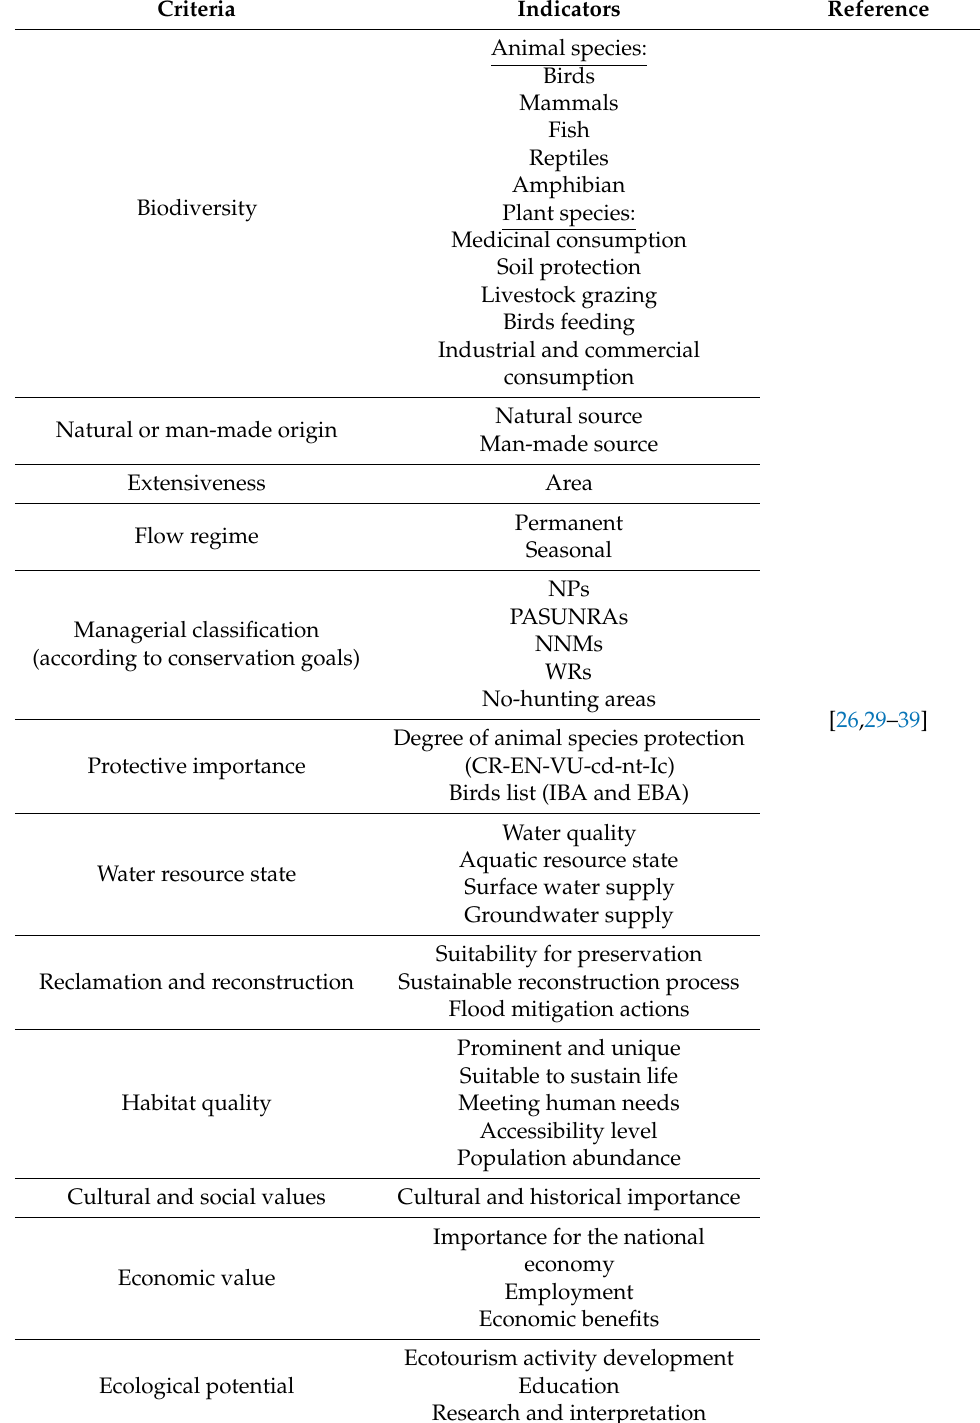
Table 1. Effective criteria and indicators to prioritize water